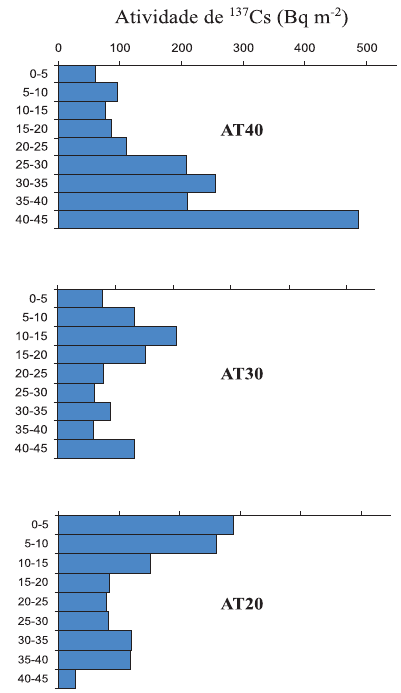
Figura 3. Análise detalhada da atividade de 137 Cs nas trincheiras abertas na área de mata ciliar, na transeção